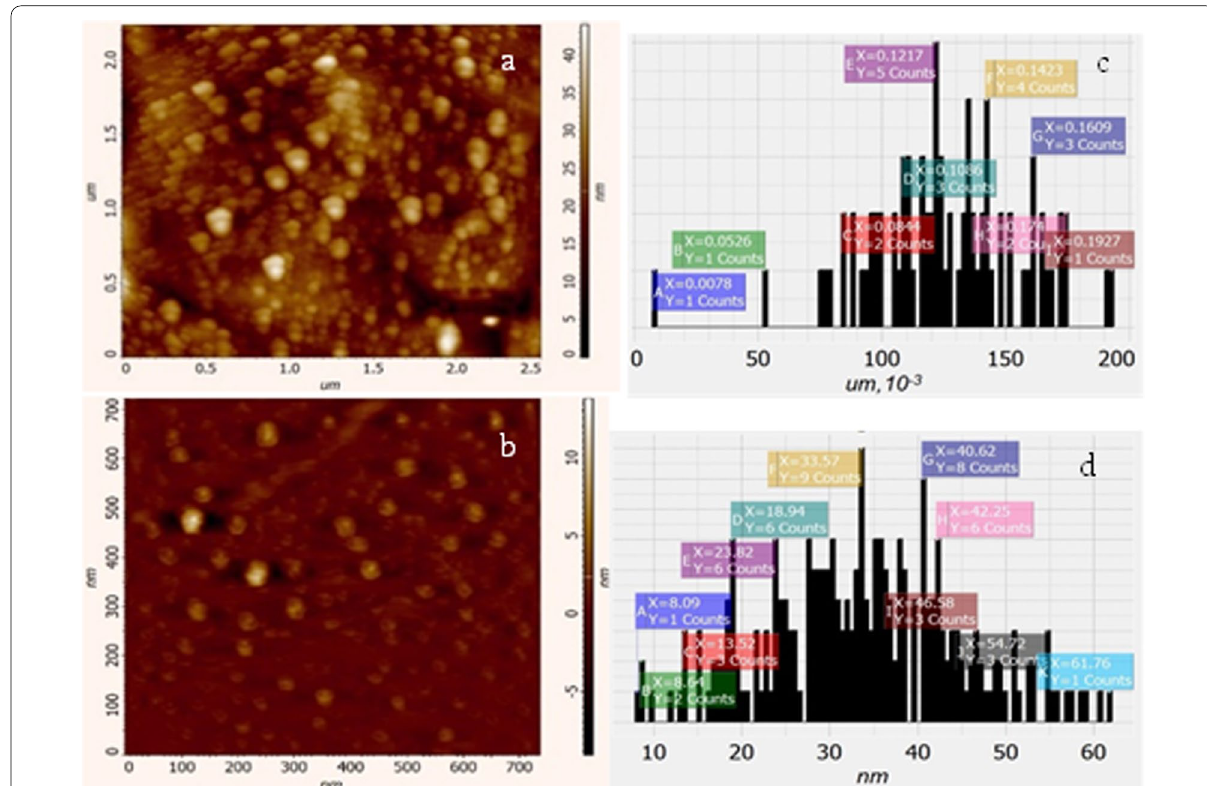
Fig. 5 AFM images of non-treated (ultrasound-treated a ( b )) and average size distribution c ( d ) of Ag NPs